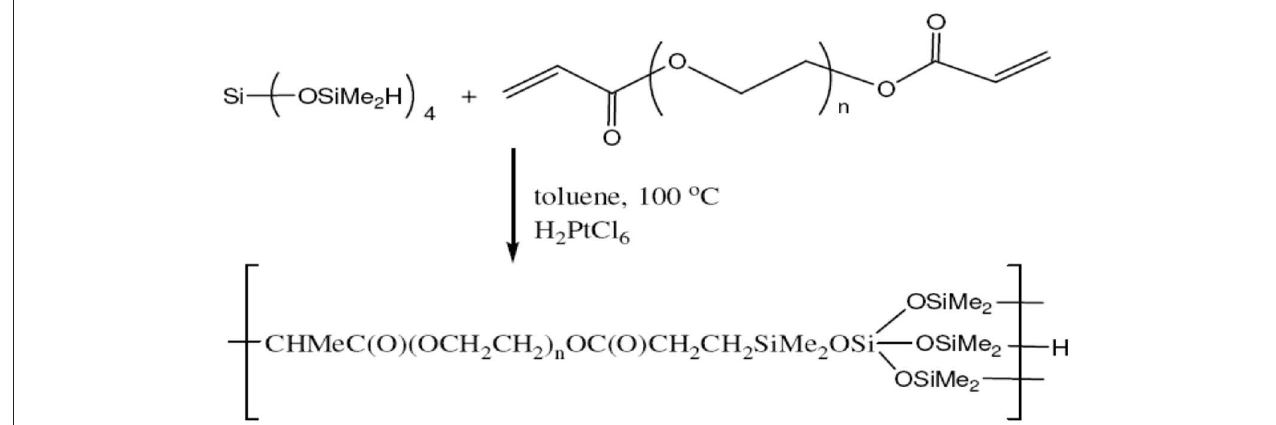
FIGURE 1 | Synthesis of Si-H terminated